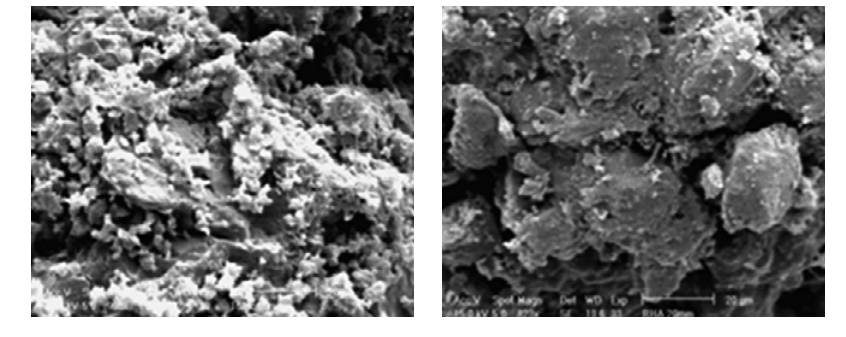
Figure 8. Scanning Electron Microscopy of